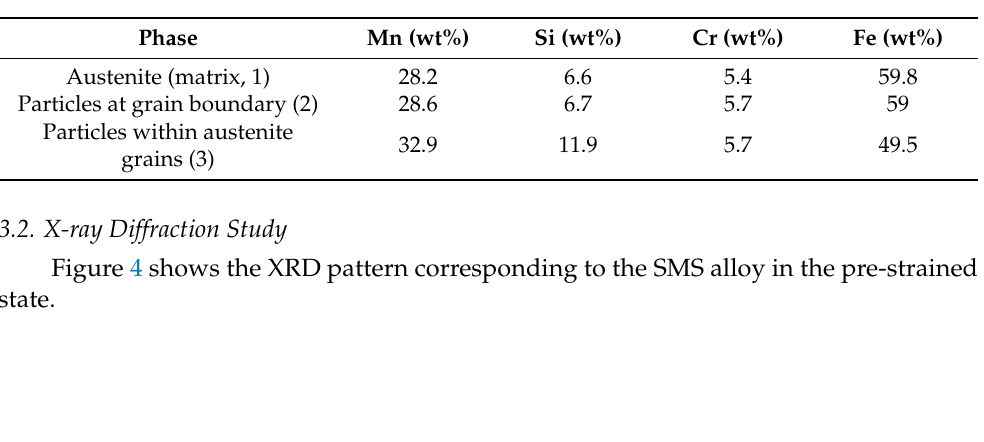
Table 1. EDS analysis corresponding to the phases and particles identified in Figure 3.